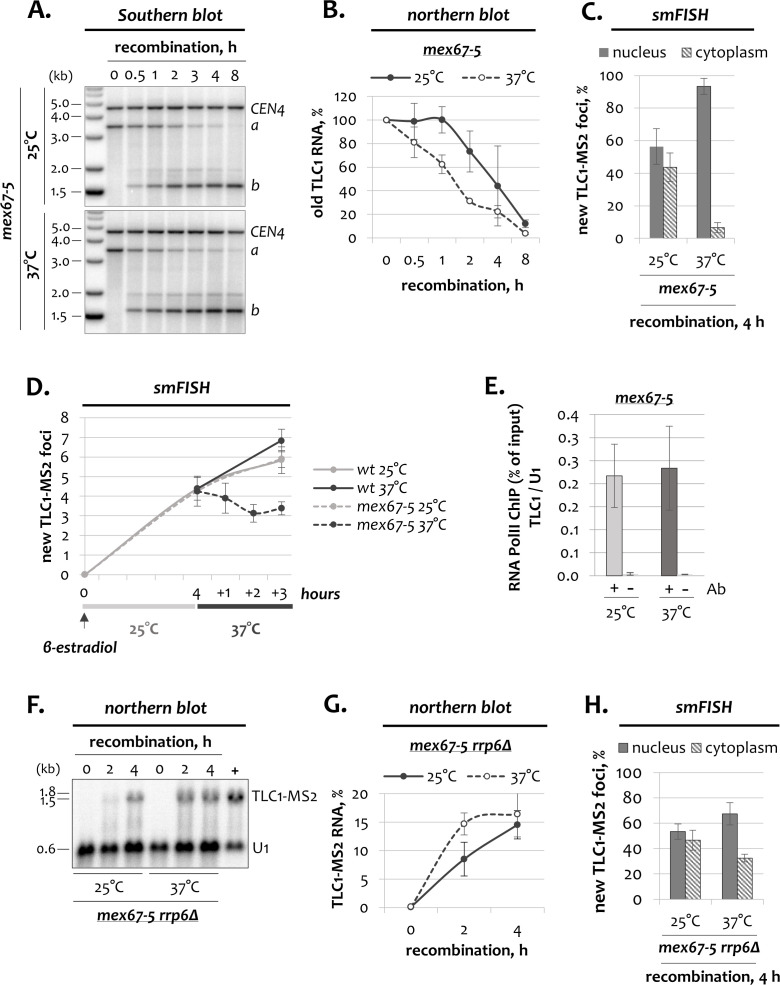
TLC1 dynamics in mex67-5 cells.(A) Southern blot analysis of the TLC1-[MS2-IN] locus following induction of recombination in mex67-5 cells grown at the permissive and restrictive temperatures. The position of the TLC1 probe hybridizing to restriction fragments a and b is depicted in Figure 1A. CEN4 – loading control. DNA marker sizes are indicated on the left (kb). (B) Northern blot quantification of old (untagged) TLC1 RNA following recombination induction in mex67-5 cells grown at the permissive and restrictive temperatures. Fractions relative to 0 hr are shown. Error bars indicate SD, n = 3. (C) Relative nuclear and cytoplasmic fractions of tagged TLC1-MS2 foci detected by smFISH after 4 hr of recombination in mex67-5 cells grown at 25 and 37°C. 50–100 cells from three independent experiments were scored. Error bars indicate SD. (D) Average number of new TLC1-MS2 foci detected by smFISH in wild type and mex67-5 cells. After addition of β-estradiol, cells were grown for 4 hr at 25°C, followed by temperature shift to 37°C. 50–100 cells from three (mex67-5) and two (wt) independent experiments were scored. Error bars indicate SD. (E) RNA Pol II ChIP (% of input) at the TLC1 locus normalized to the U1 locus in mex67-5 cells grown at 25 and 37°C. ‘+/-’ – with/without anti-RNA Pol II antibody. (F) Northern blot analysis of tagged TLC1-MS2 RNA transcripts following induction of recombination in mex67-5 rrp6Δ cells grown at 25 and 37°C. The blot was hybridized with the MS2-specific probe. U1 – loading control. ‘+’ - positive recombined control. RNA sizes are indicated on the left (kb), 1.8 kb corresponds to 18S rRNA. (G) Quantification of the northern blot shown in F. Fractions relative to the positive recombined control (+) are shown. Error bars indicate SD, n = 2. (H) Relative nuclear and cytoplasmic fractions of tagged TLC1-MS2 foci detected by smFISH after 4 hr of recombination in mex67-5 rrp6Δ cells grown at 25 and 37°C. 50–100 cells from three independent experiments were scored. Error bars indicate SD.Figure 4—figure supplement 1—source data 1.Numerical data used to generate Figure 4—figure supplement 1.